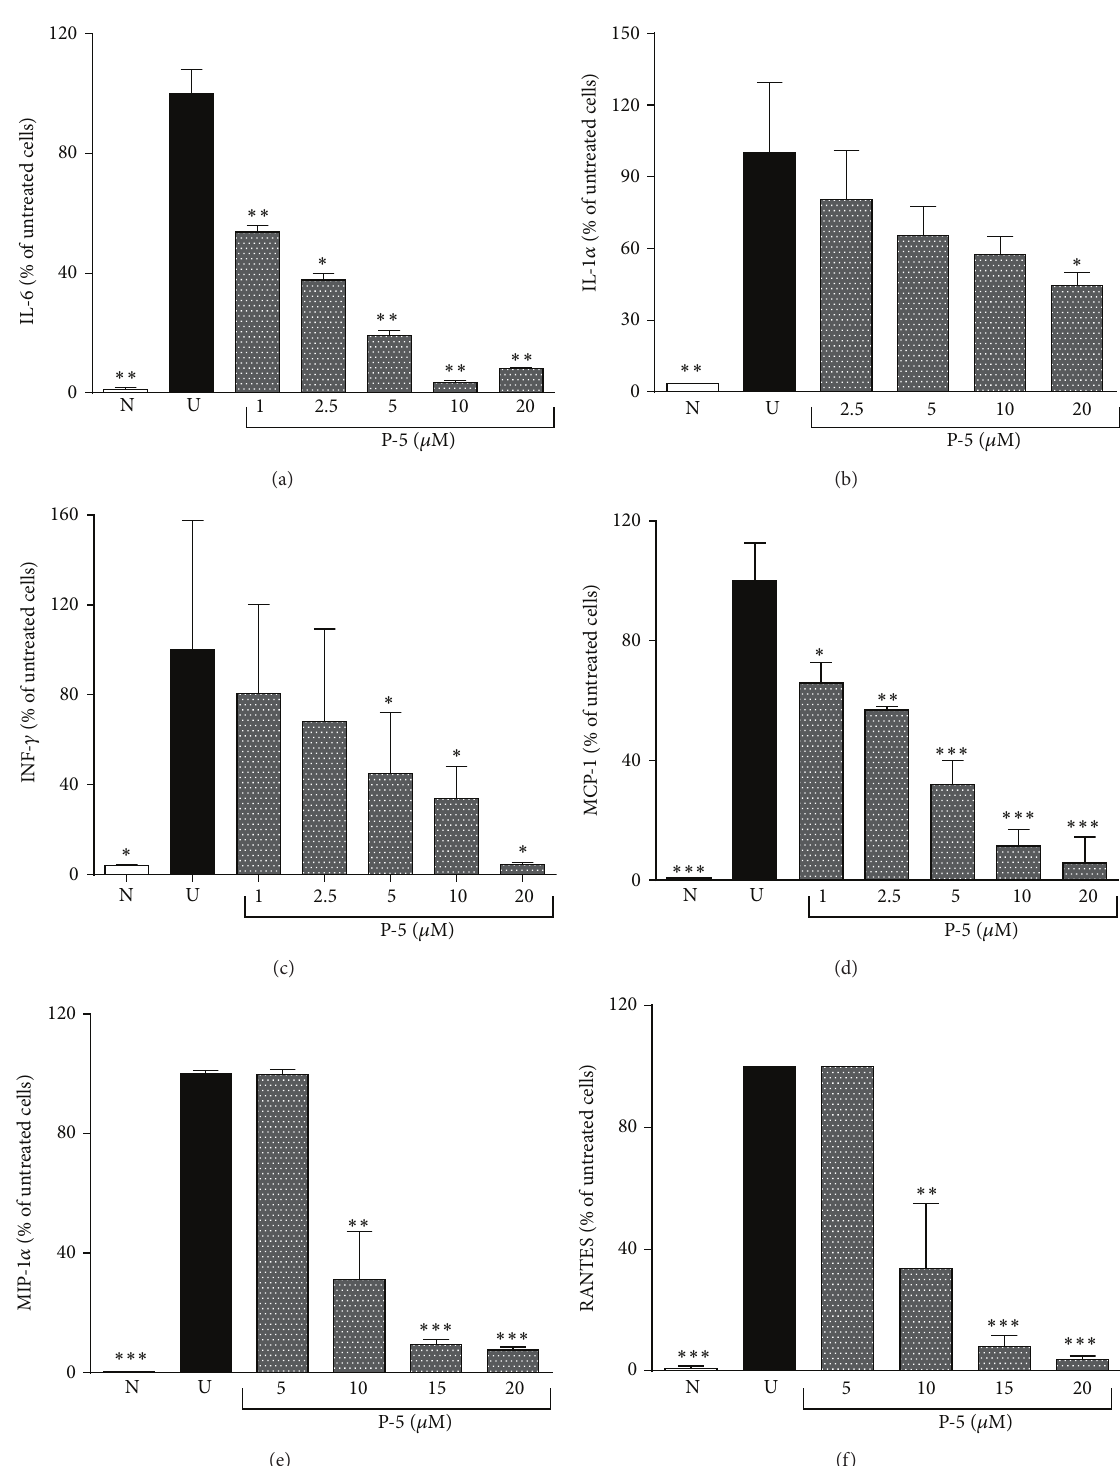
Figure 4: The attenuating effect of P-5 on the secretion of IL-6, IL-1 𝛼 , INF 𝛾 , MCP-1, MIP-1 𝛼 , and RANTES in LPS-activated macrophages. Results are expressed as the fraction (in %) of the cytokine level secreted by untreated activated cells. N: naive control; U: untreated control. Shown are the mean results ± S.D. ( 𝑛 = 3-4). ANOVA of the effect of P-5 at a series of concentrations on IL-6 levels was F 7,33 = 115.36, 𝑝 < 0.001 , on INF 𝛾 was F 𝑝 < 0.01 , on MCP-1 was F 𝑝 < 0.00001 , on MIP-1 𝛼 𝑝 < 0.00001 , on IL-1 𝛼 was F 6,20 = 8.06, 6,19 = 4.64, 6,20 = 73.57, was F 7,23 = 219.00, 𝑝 < 0.00001 , and on RANTES was F 5,17 = 100.54, 𝑝 < 0.00001 . ∗ 𝑝 < 0.05 ; ∗∗ 𝑝 < 0.01 ; ∗∗∗ 𝑝 < 0.001 compared to untreated